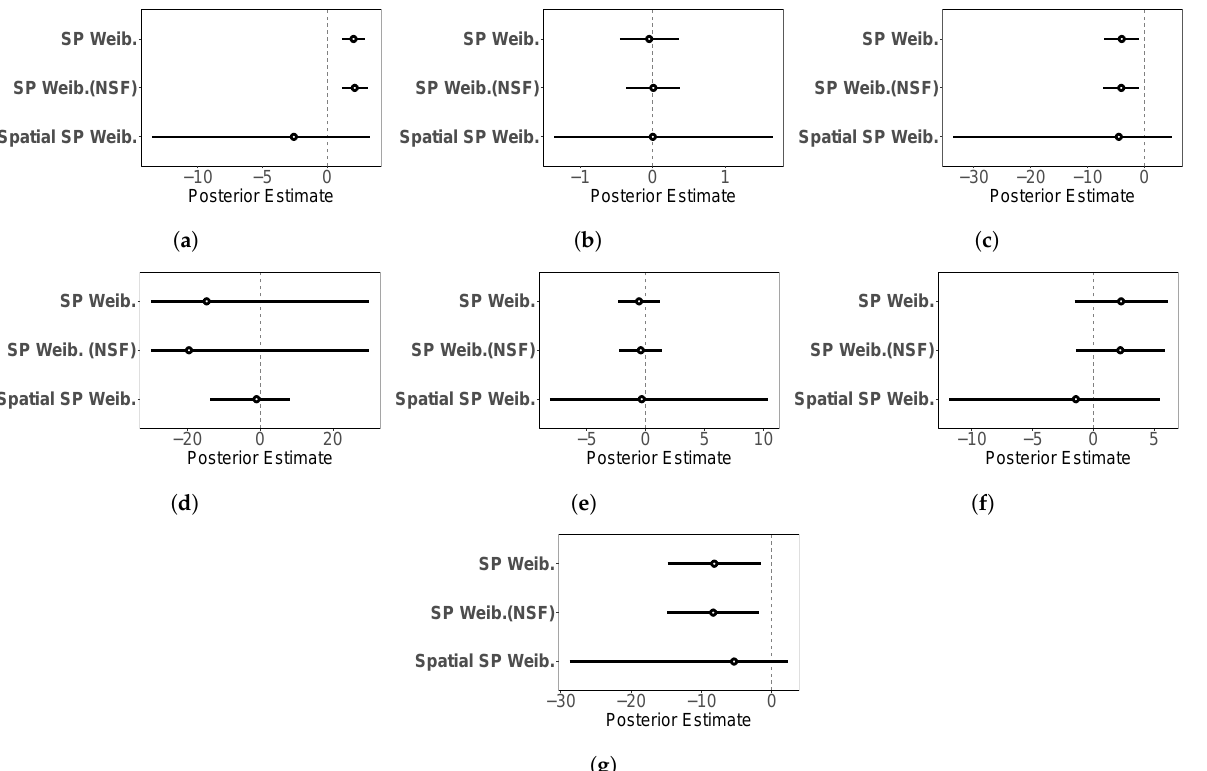
Figure 5. Democratic consolidation stage ( ˆ γ ) coefficient results from SP Weibull, NS Frailty SP Weibull, and spatial SP Weibull models for the following covariates: ( a ) GDP/cap, ( b ) GDP growth, ( c ) military government, ( d ) monarchy, ( e ) civilian government, ( f ) parliamentary government, and ( g ) presidential